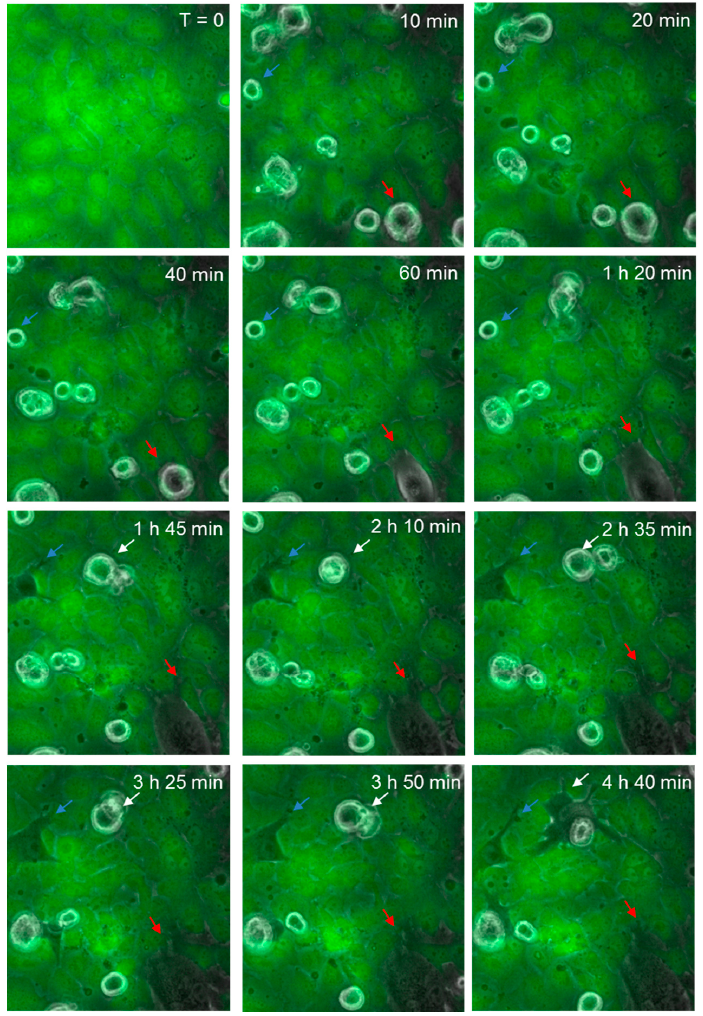
Figure 8. Time-lapse series illustrating melanoma cells (NZM74) integrating into hCMVEC endothelial layer. Images show endothelial cells stained with CMFDA (green), merged with phase only to visualize unstained spherical melanoma cells. Coloured arrows indicate melanoma cells that extend protrusions between endothelial cells, which over time enable them to penetrate the endothelial monolayer. Images shown are representative of two independent